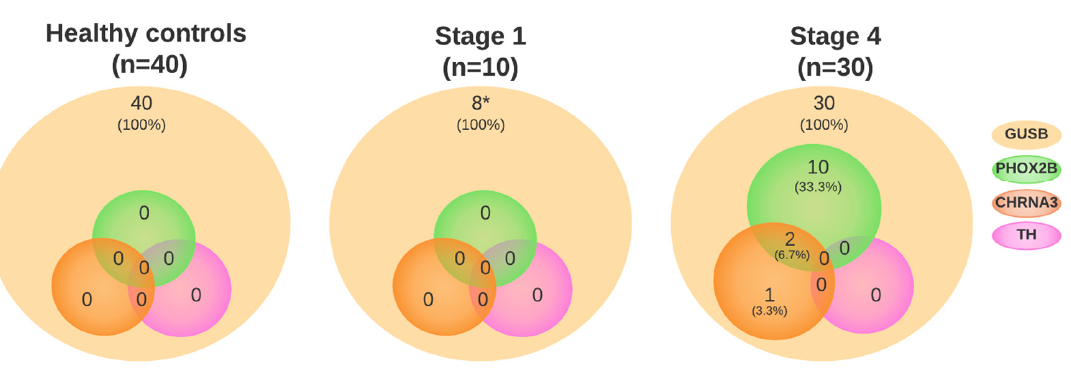
Figure 1. Expression of neuroblastoma-specific genes in cell-free RNA from healthy controls ( n = 40), and diagnostic plasmas from patients with neuroblastoma with localized ( n = 10) and metastatic ( n = 30) disease. * Not enough material was left for 2 patients to perform the ddPCR for these neuroblastoma-speci fi c markers.